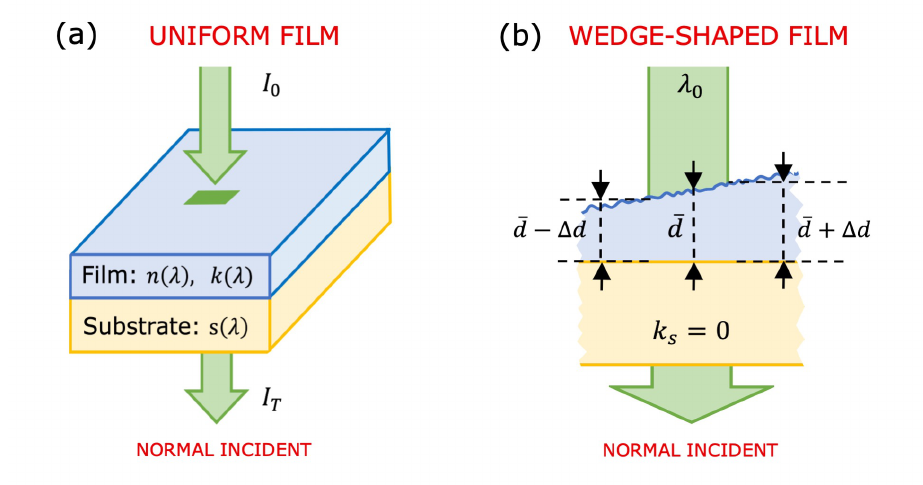
Figure 2. A schematic representation of the geometry of ( a ) a uniform, and ( b ) a nonuniform weakly-absorbing thin film, onto a thick non-absorbing glass